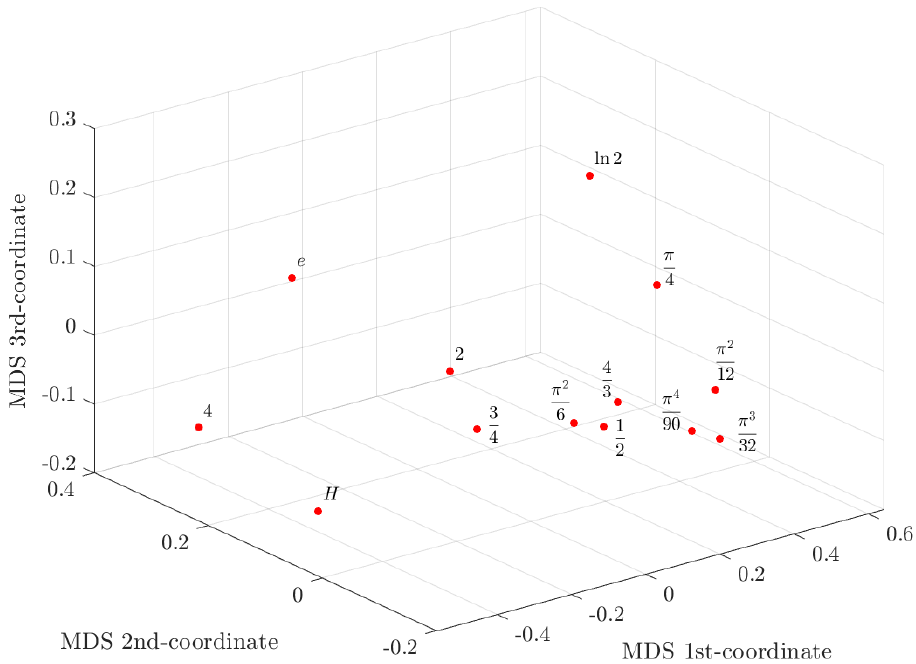
Figure 4. MDS loci of the numerical series S i , i = 1, . . . ,13, produced by the ArcCosine distance, d Ac , for r =